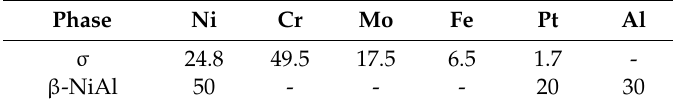
Table 2. Chemical composition of σ and β-NiAl type phase, at %.